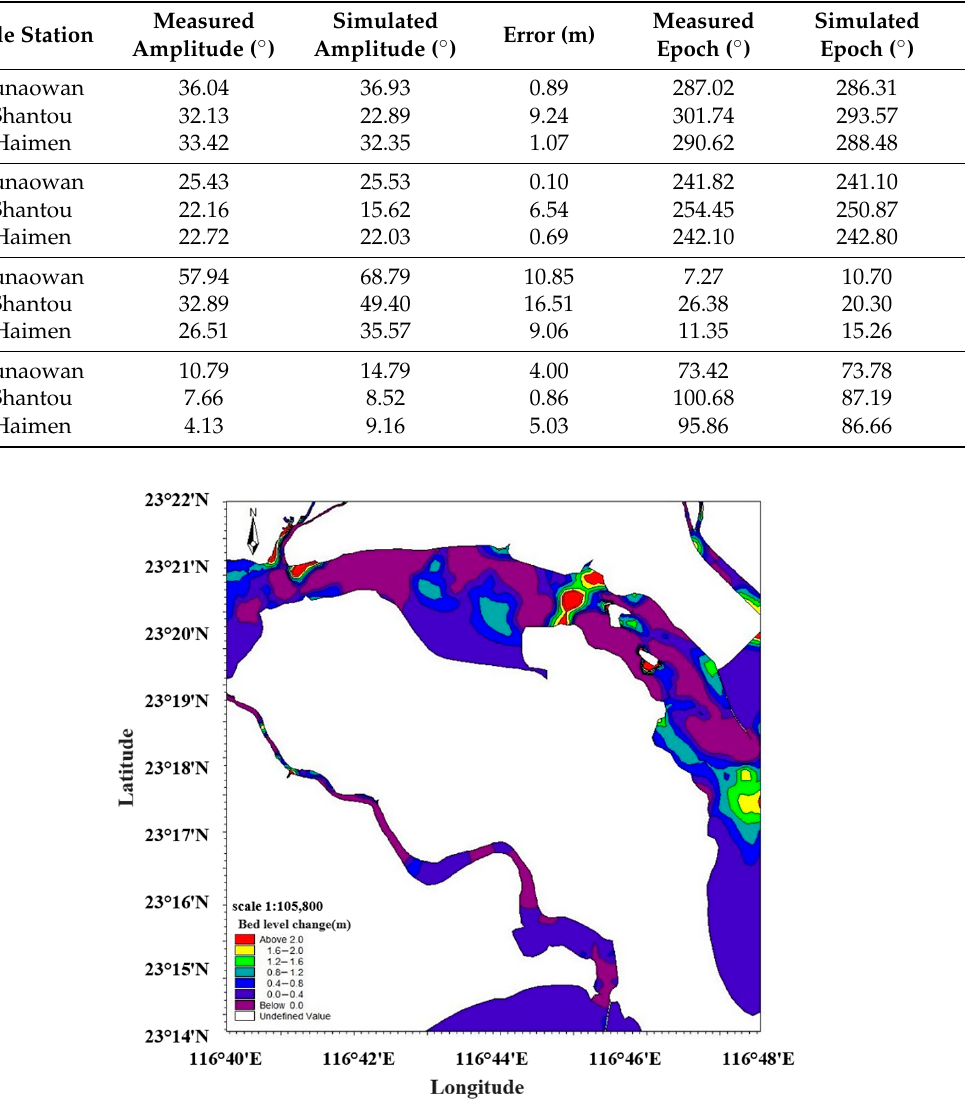
Figure 3. Grid setting in Shantou offshore (the red box in the figure is the coastal area of Shantou City where the grid resolution is up to 100 m).